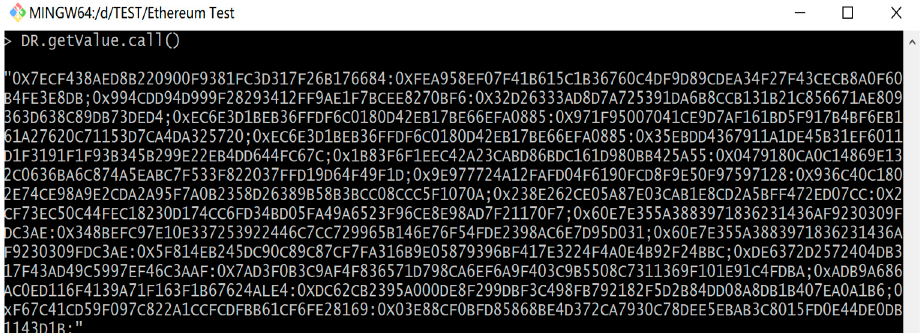
Figure 7. The data attribute value of DP register contract.